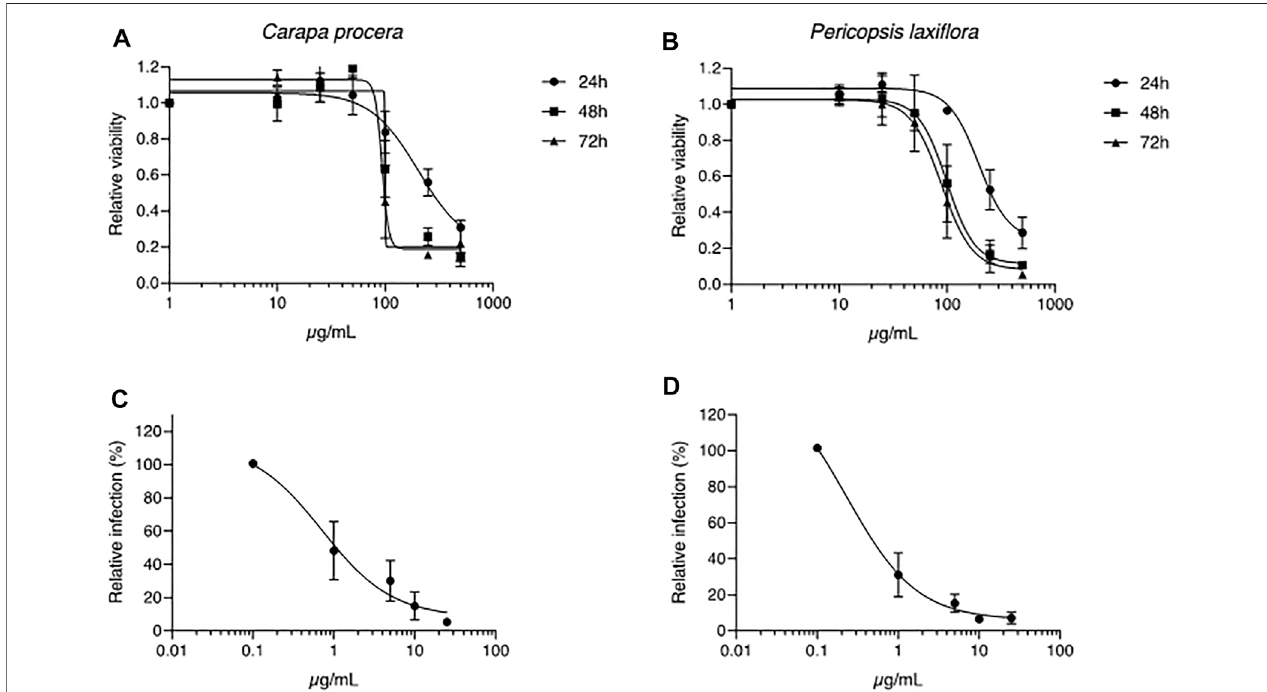
FIGURE 2 | Toxicity and antiviral assays of C. procera and P. laxi fl ora crude extracts. (A, B) : Huh-7 cells were incubated with culture medium containing crude extracts at different concentrations. MTS toxicity assay was performed at 24, 48 or 72 h of incubation. (C, D) : Huh-7 cells were inoculated with HCV in the presence of crude extracts at different concentrations. Infected cells were quanti fi ed 30 h post infection by immuno fl uorescence detection of viral E1 protein. Data are presented relative to untreated control. Data are means ± SEM of 3 experiments performed in triplicates.